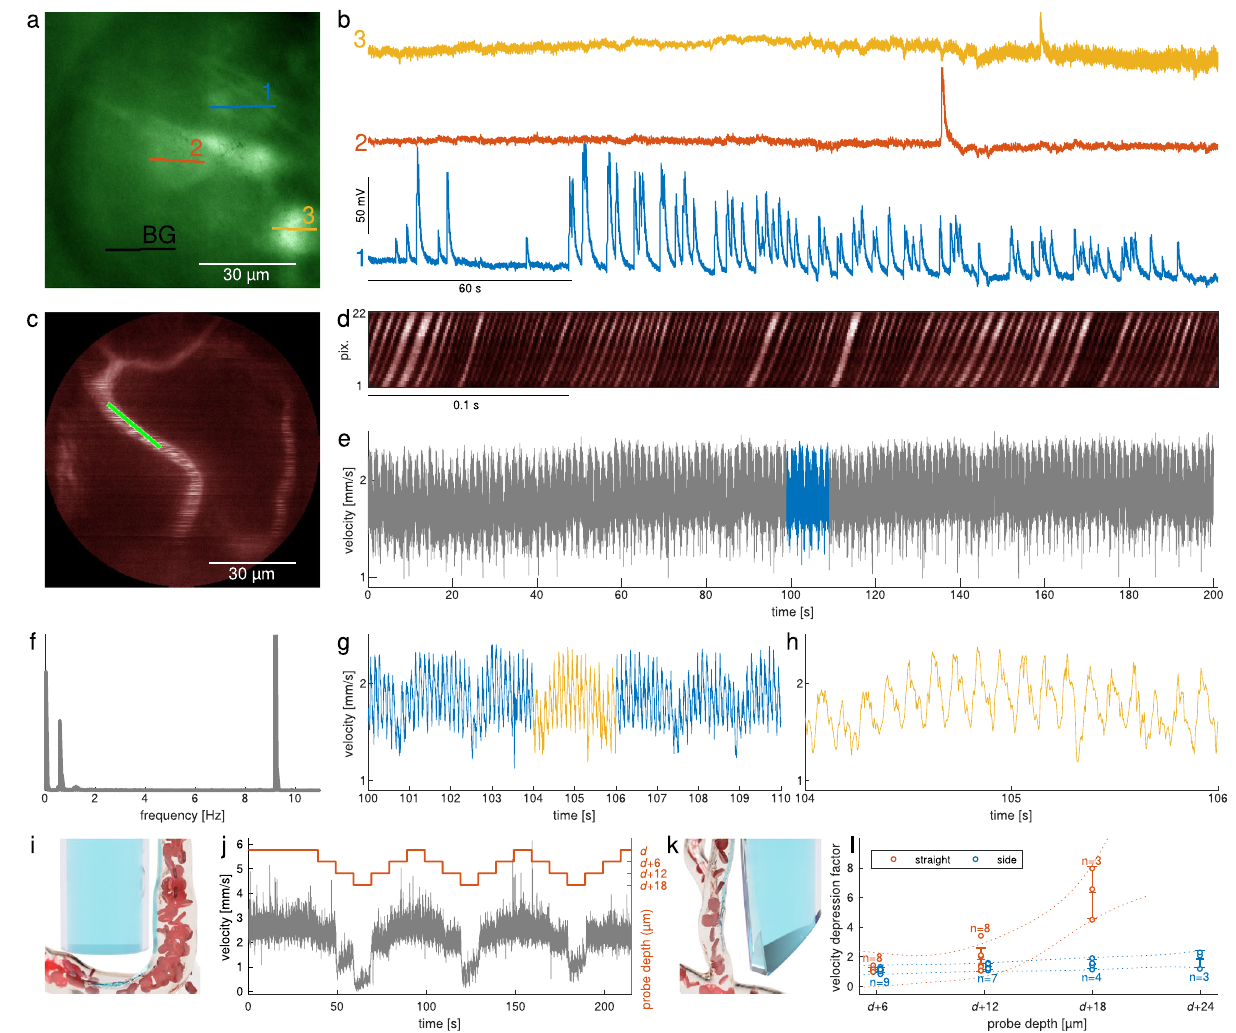
fl ow velocity measured atdepth d ( fi bre facet is ≈ 40 μ m above the imaged vessel), d +6, d +12 and d +18 μ m during insertion and retraction of the probe in 3 cycles. k Arrangement of blood fl ow measurement in the side-view regime. l Velocity depression (the factorby which the blood fl owspeed hasbeen reduced due tothe vertical movement of the probe) for an interval of probe depths. The error bars indicate standard deviation. The corresponding dotted lines enclose the 99% con fi dence intervals obtained from the third order polynomial regression of the complete respected datasets, while forcing the model function to pass the point [ d